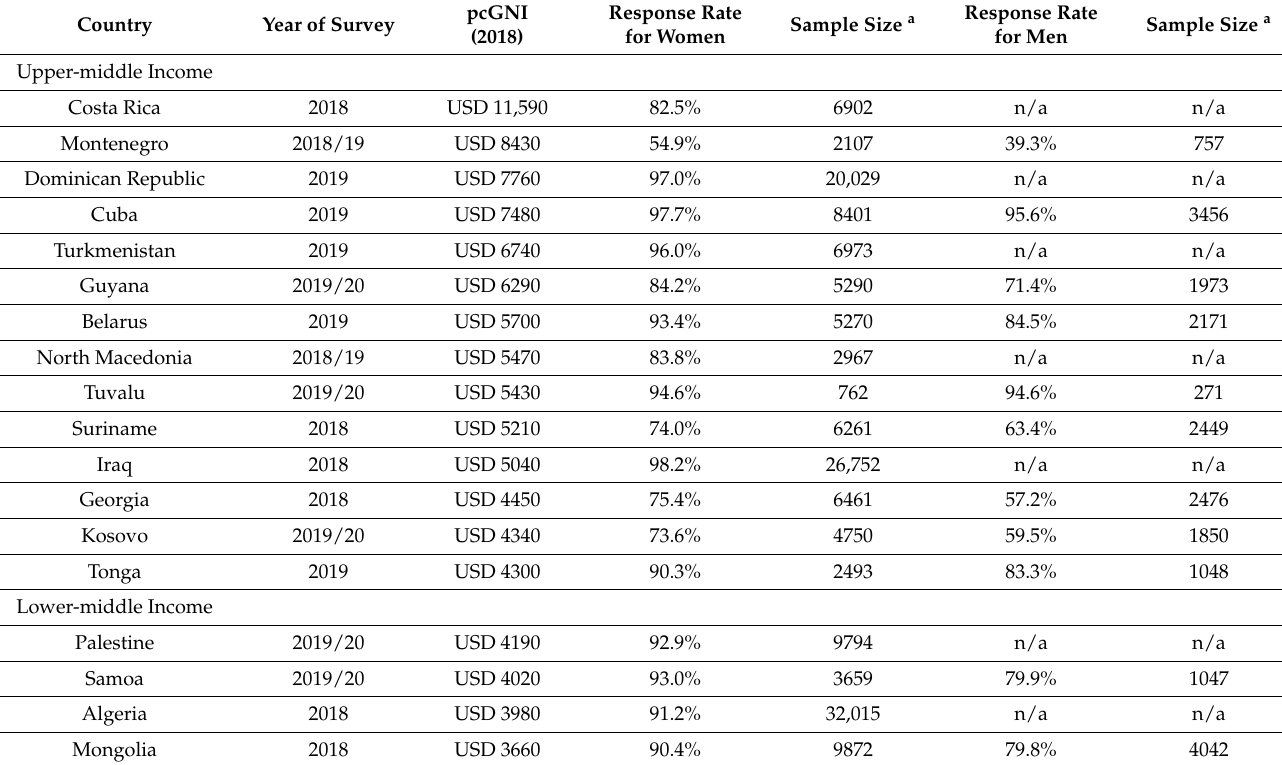
Table 1. Country-level survey data for 37 middle- and low-income